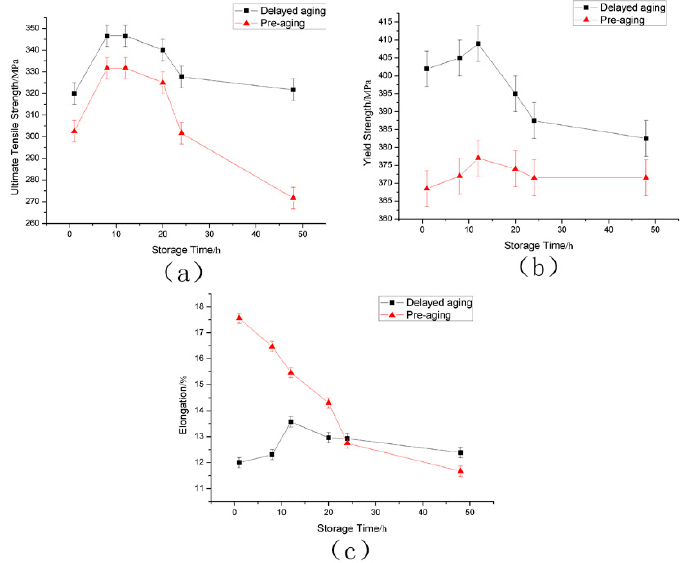
Figure 8. Tensile mechanical properties of the alloys treated with two different aging: ( a ) ultimate tensile strength; ( b ) yield strength; ( c ) elongation.